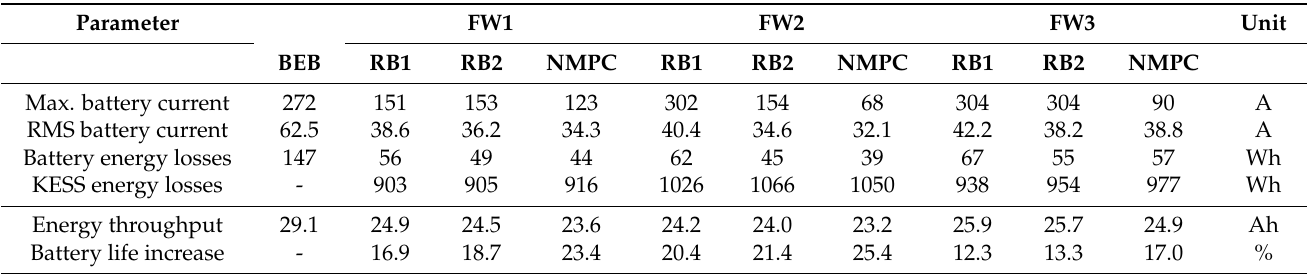
Energy throughput Battery life increase